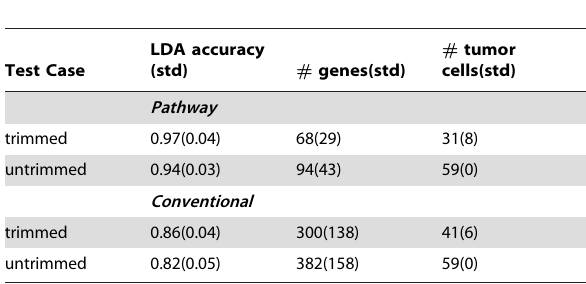
Table 1. Average results for LDA